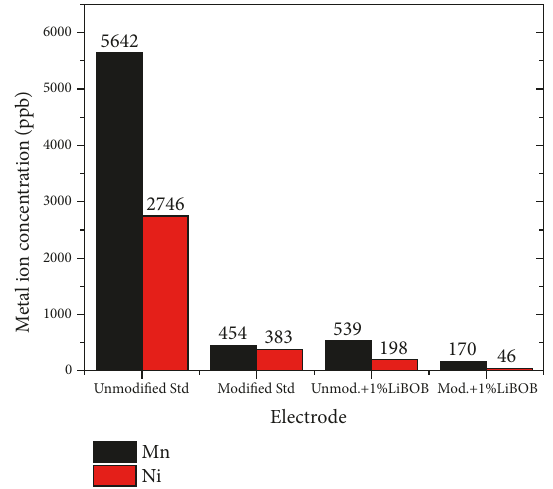
Figure 5: Mn and Ni concentrations in the anode electrodes of the cycled full cells, as from ICP-MS